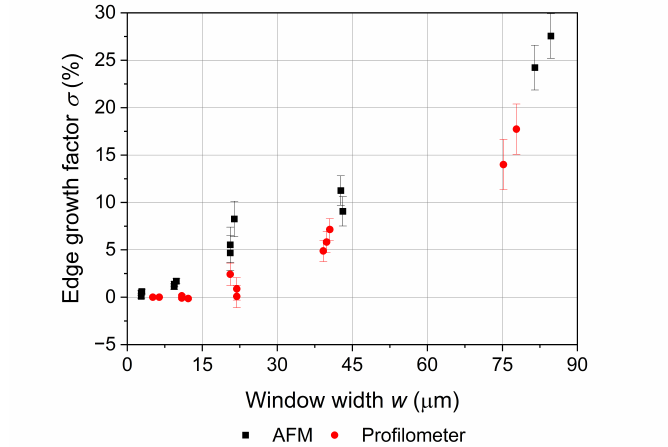
Figure 14. Edge growth factor as a function of window width σ = f ( w ) (layer thickness 250 nm); comparison of optical profilometer and atomic force microscope (AFM).